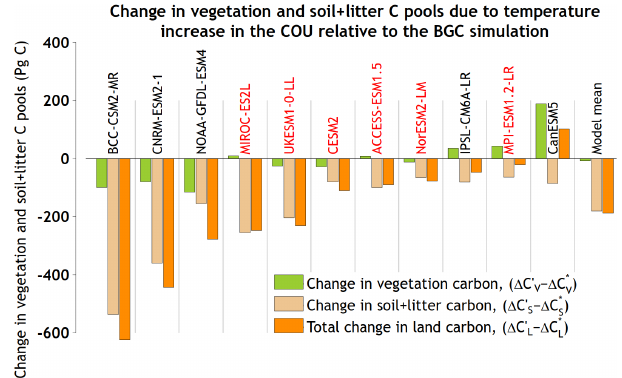
Figure 9. The changes in vegetation and soil + litter carbon pools in the COU relative to the BGC simulation, as shown in Eq. (9), which contribute to the calculation of the carbon–climate feedback over land ( γ L ) in the BGC–COU approach. The names of models which include the N cycle are shown in a red font colour.